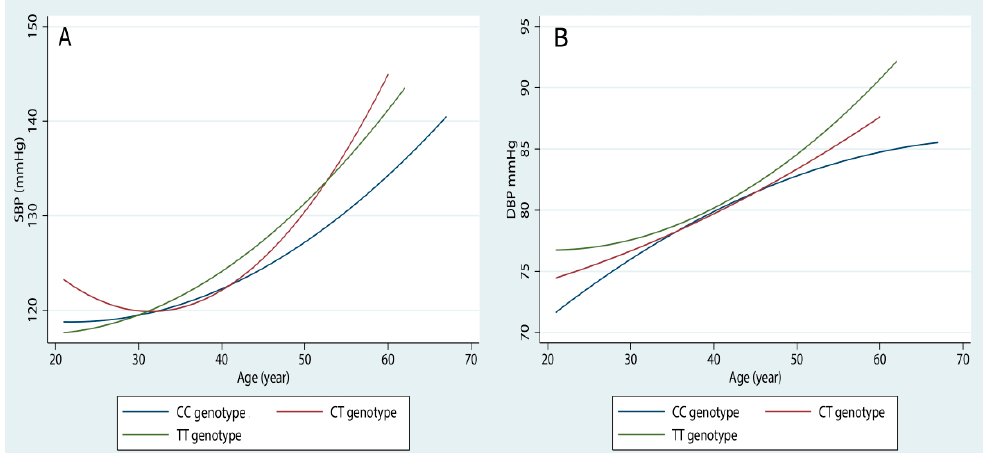
Figure 1. The effects of age on SBP ( A ) and DBP ( B ) levels in different MTHFR C677T genotype groups.